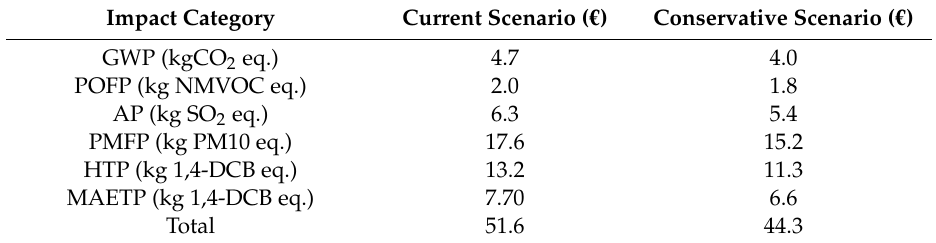
Table 4. Potential costs of damages on human health and environment due to air emissions of fuel combustion for vegetation removal in 1 km of